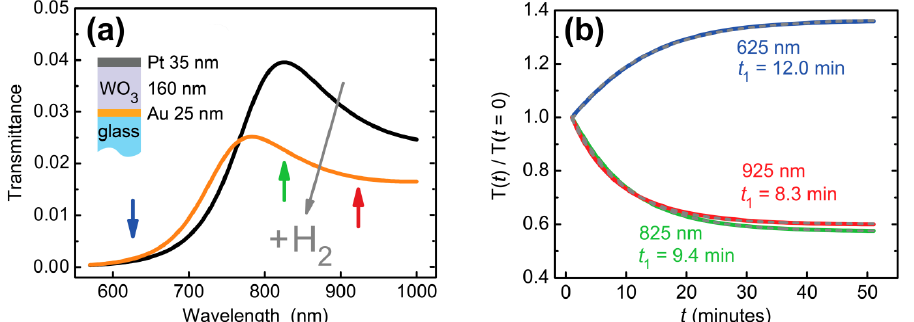
Figure 3. ( a ) Transmittance dynamics of WO 3 -based sensing element exposed to 200 ppm hydrogen in nitrogen. ( b ) Normalized transmittance for selected wavelengths (shown in Figure 3a by arrows): initial position of the maximum (766 nm); the position of the maximum 1 h after the supply of hydrogen (713 nm); left (600 nm) and right (900 nm) boundaries of the observation area. Response times retrieved from a single-exponential fit ( t 1 ) are shown near the curves (in minutes).